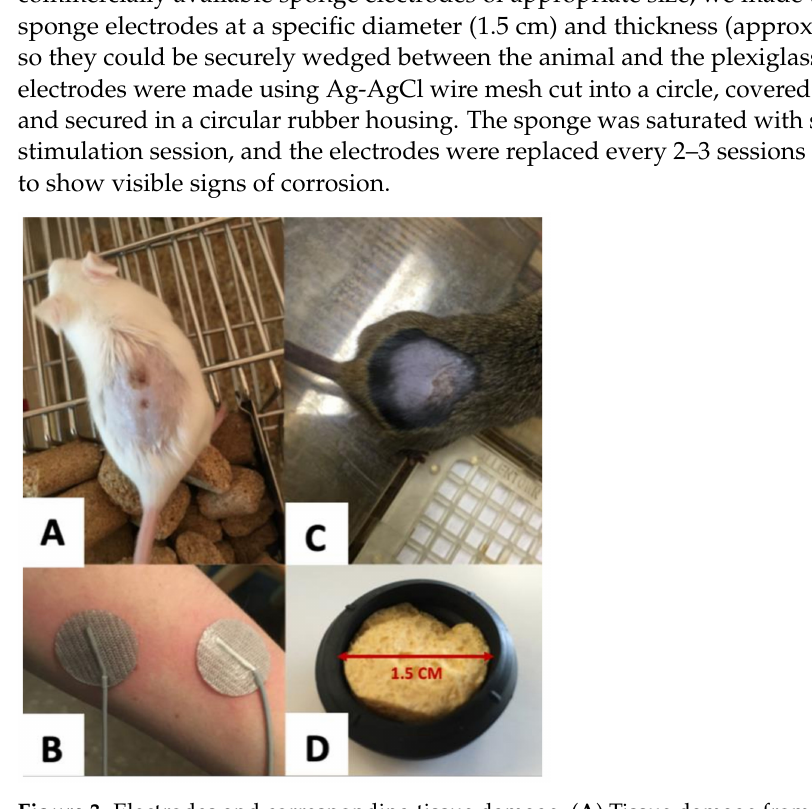
Figure 3. Electrodes and corresponding tissue damage. ( A ) Tissue damage from Ag-AgCl adhesive electrodes. ( B ) Ag-AgCl adhesive electrodes. ( C ) Tissue damage from saline-soaked sponge electrodes. ( D ) Homemade saline-soaked sponge electrode (also see Figure 1A for visual of the electrode size relative to the